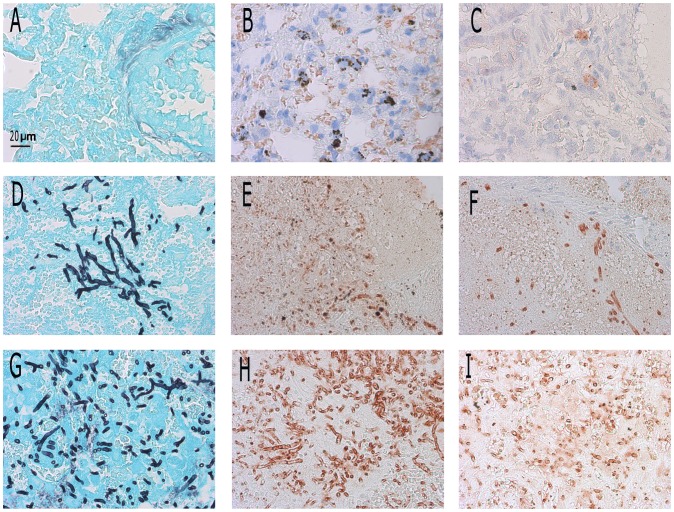
Grocott staining (A, D, G) and presence of AMCase (B, E, H) and chitotriosidase (C, F, I) in several rats.Panels A, B, and C show the lung of an uninfected rat. Panels D, E and F show the fungal focus in an infected, untreated rat. Panels G, H and I show the fungal focus in an infected, caspofungin treated rat. Original magnification ×400. All panels represent lungs on day 6 after inoculation. Slides were stained according to the described protocols. In Grocott staining (A, D, G), fungal hyphae are coloured black. Chitotriosidase- or AMCase-presenting cells are coloured red (B, C, E, F, H, I). In uninfected rats, normal morphology can be found in the lungs (A, B, C). In infected rats, normal morphology of alveoli is lost (D, E, F). Grocott staining shows many hyphae (D). An inflammatory response is found around the fungal focus, where chitotriosidase and AMCase are increasingly present (red zones) compared to an uninfected rat (E, F). After treatment with caspofungin, Grocott staining shows fungal material in all infected rats (G). AMCase bound fungal hyphae after treatment with caspofungin (H) and thus hyphae became visible. After treatment with caspofungin, chitotriosidase seemed to also bind the fungal cell wall and locate inside hyphal cells (I).